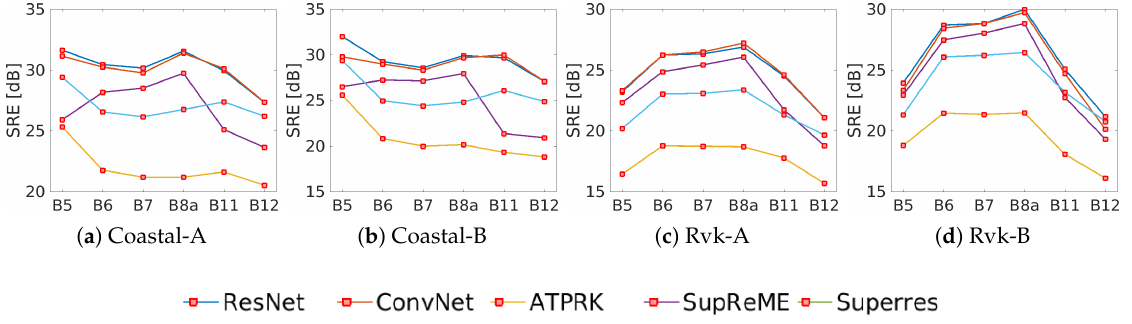
Figure 11. Residual images for all methods and bands of the Coastal-A data set. Blue indicates negative residuals and red indicates positive residuals.